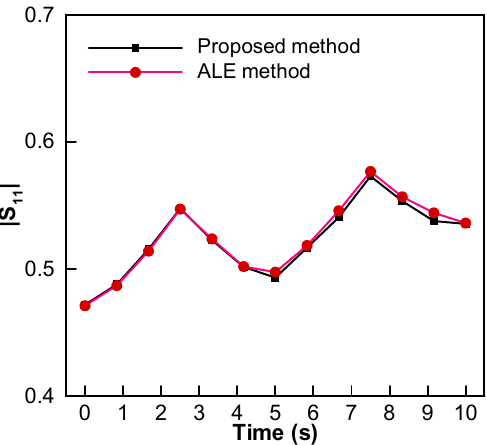
Figure 6. | S 11 | computed by the proposed method and the ALE Figure 6. |S 11 | computed by the proposed method and the ALE method. Figure 6. |S 11 | computed by the proposed method and the ALE method.